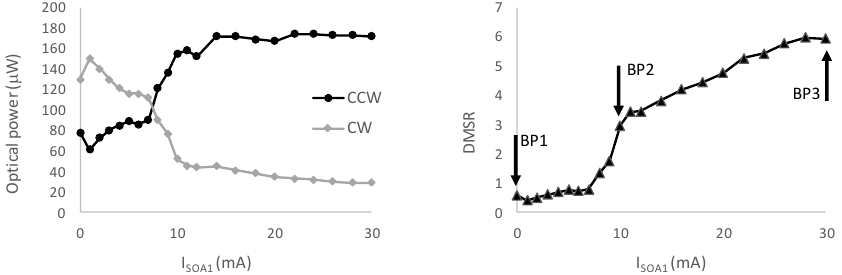
Figure 4. Output power of the two directional modes versus current injected in the semiconductor optical amplifier (SOA) in the FOF arm 2 (left) and directional mode suppression ratio as a function of the SOA current in the FOF arm (right) at a laser injection current of 60 mA.